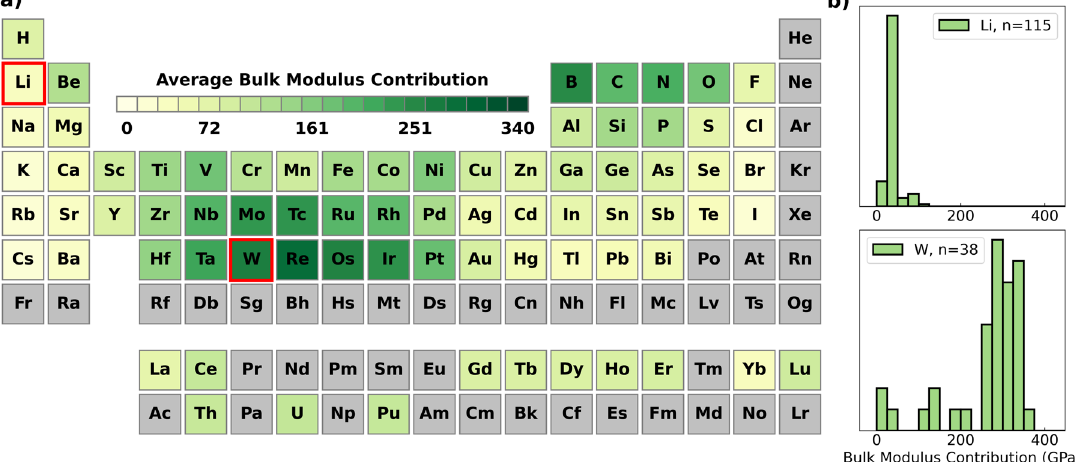
Fig. 4 Overall element contribution to property predictions. Average contribution of all elements to bulk modulus predictions, computed from the AFLOW bulk modulus dataset, ( a ) plotted on a periodic table and ( b) plotted as a distribution showing the per-element contribution amounts of Li and W, respectively, in all the compounds. The darker colored elements in the periodic table contribute more towards a compound ’ s bulk modulus